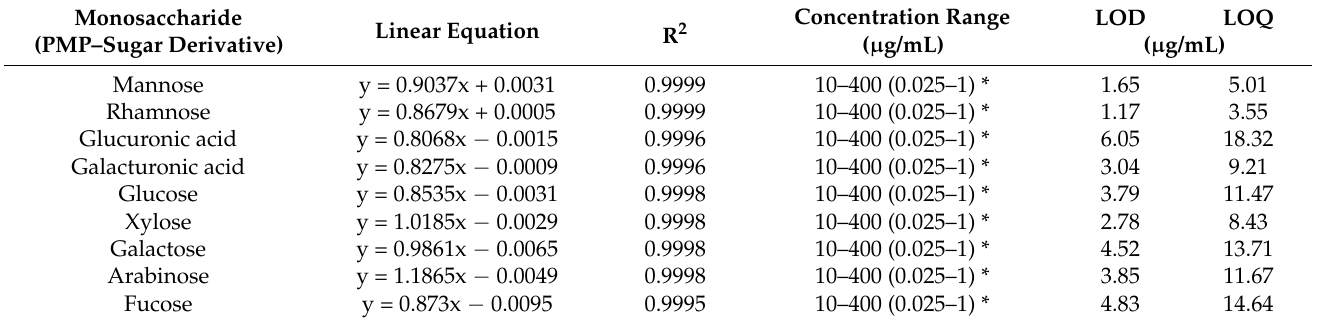
Table 1. Linearity parameters, limit of detection (LOD) and limit of quantification (LOQ) of the developed HPLC-DAD method for the analysis of PMP–sugar